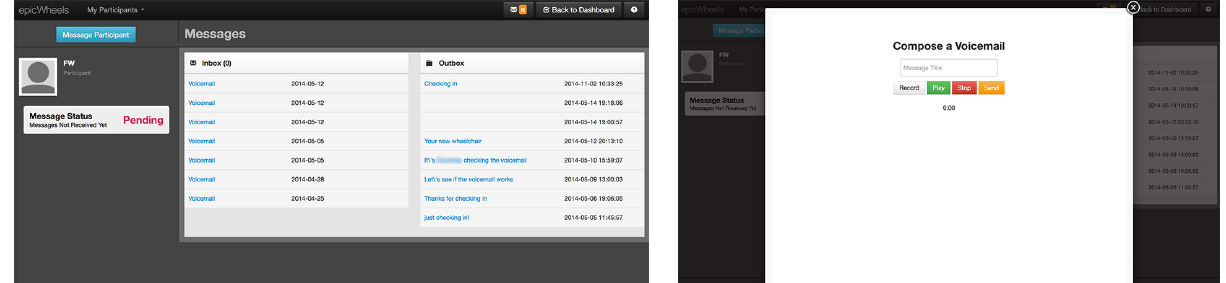
Figure 9. Trainer voice-messaging